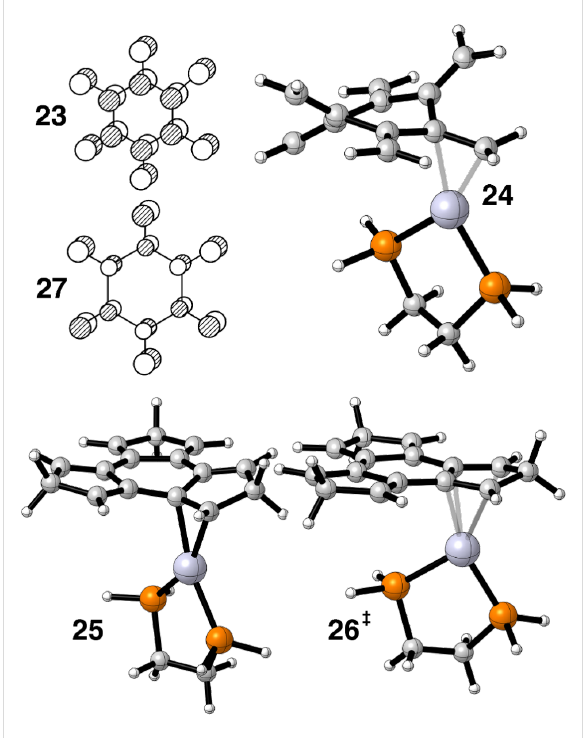
Figure 7: The LUMO, 23 , and HOMO, 27 , in 6-radialene. The opti- mized η 2 ground states are shown in 24 and 25 while 26 shows the ge- ometry for one η 4 transition